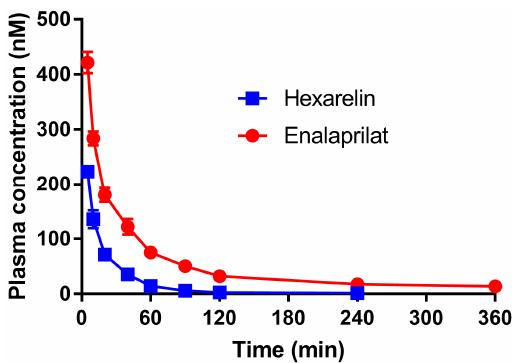
Figure 2. The mean ( ± SD) plasma concentration–time profiles ( n = 2) following the intravenous bolus administration of 0.02 mg enalaprilat and 0.05 mg hexarelin.